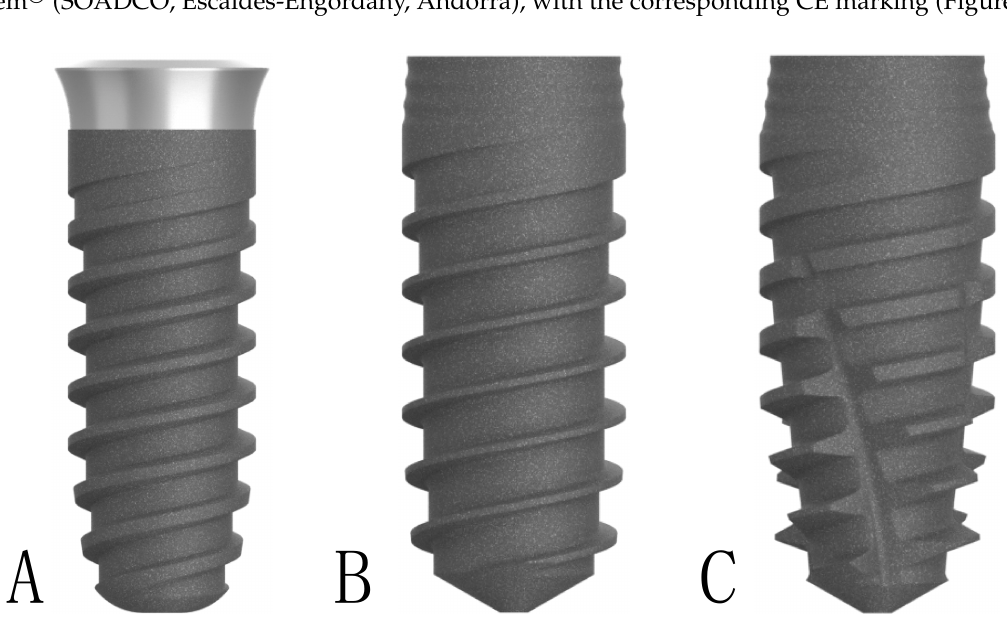
Table 1. Material properties used in finite element models.